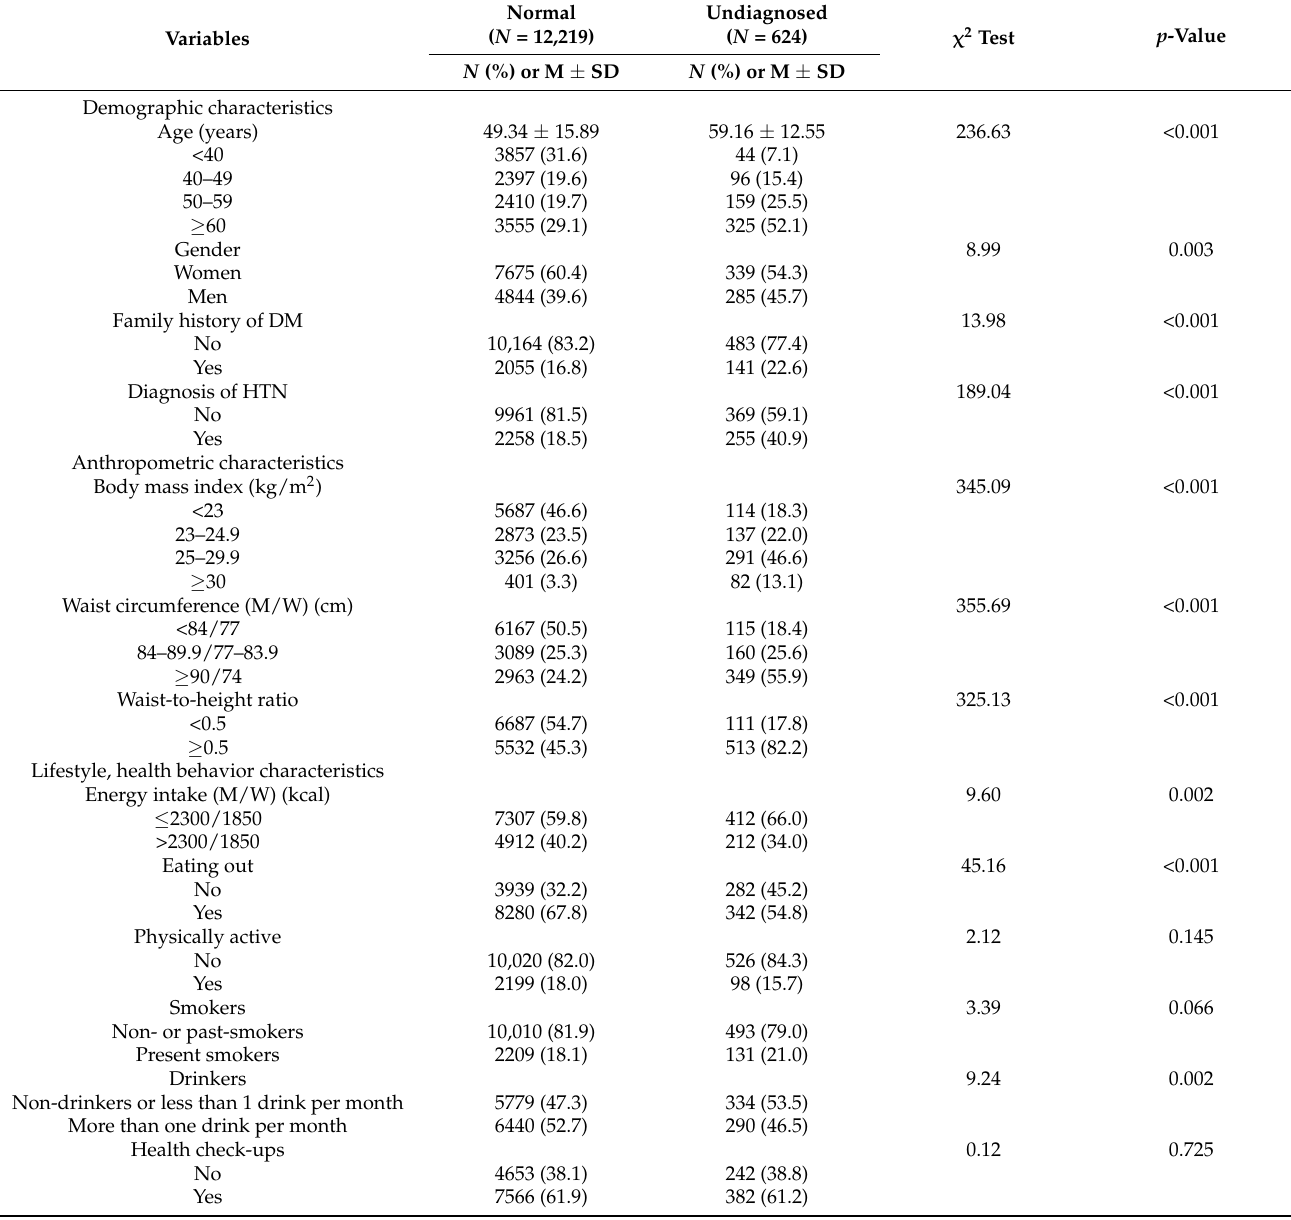
Table 1. General characteristics of participants ( N =